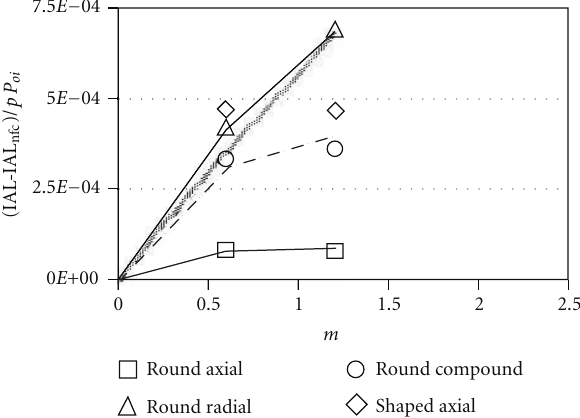
Figure 24: Normalized Integrated Aerodynamic Loss values for di ff erent hole configurations for film injection from the first row of holes only, for cambered vanes with film cooling [55]. Lines are determined using (17) and C 1 values from Table 3.